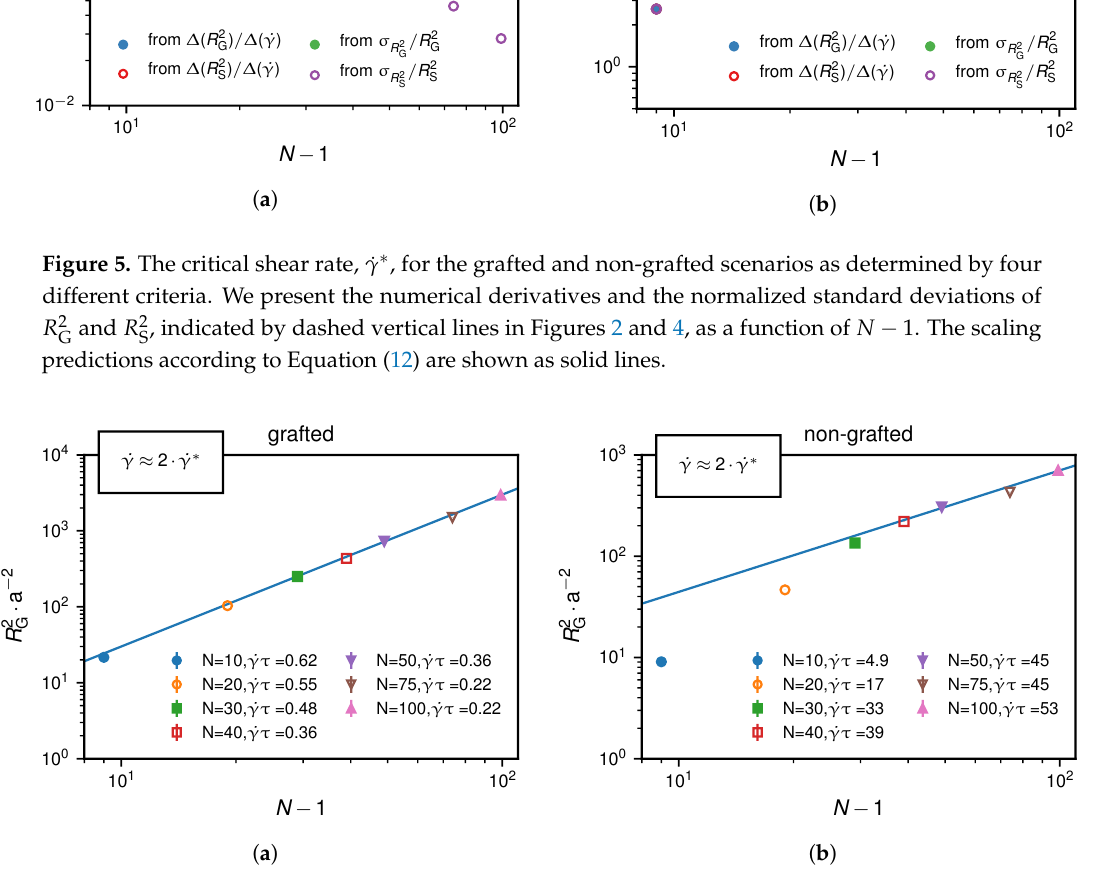
G ∼ N 2 , G ∼ N 6/5 . The scaling relations shown as G